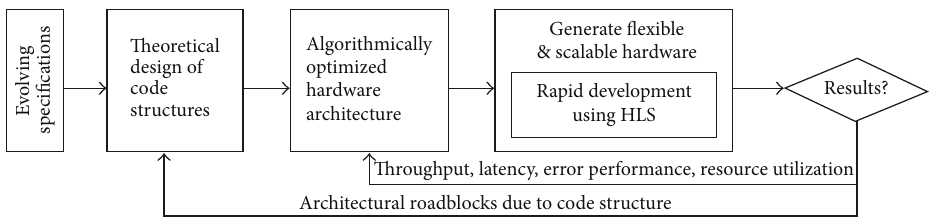
Figure 1: Illustration of our research methodology for the design and development of the channel coding architecture.